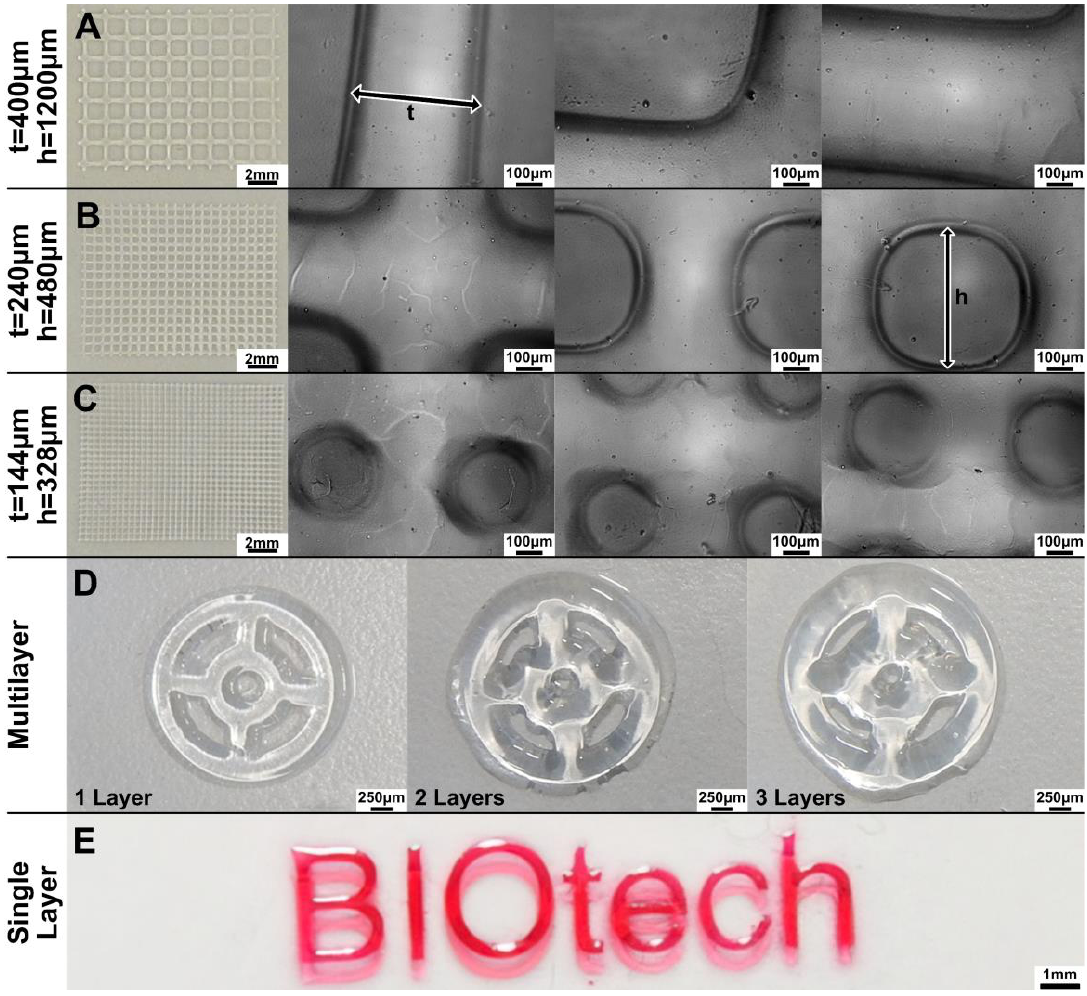
Figure 4. ( A – C ) A series of different grids were printed by the DLP projector; t indicates the length of the lines while h the side of the squared pore. By decreasing both t and h , the pores became rounded instead of squared. This could be also due to the imperfect control of the focus in our system. ( D ) Structures with more than one layer (e.g., multilayered steering wheels) were also difficult to print due to the manual adjustment. ( E ) A single-layer structure (e.g., BIOtech logo) was well-defined. The BIOtech logo has been printed, adding red food coloring to enhance the contrast.